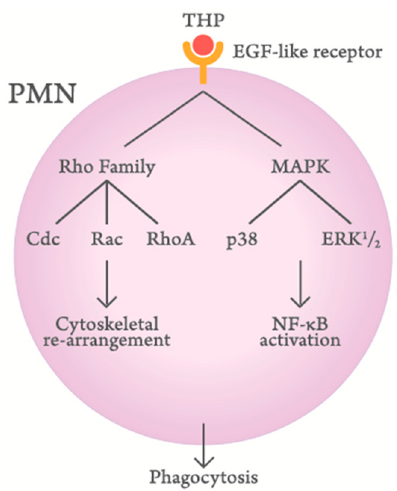
Figure 3. Scheme demonstrating the signaling pathways of Tamm–Horsfall protein (THP)-enhanced polymorphonuclear leukocyte (PMN) phagocytosis.